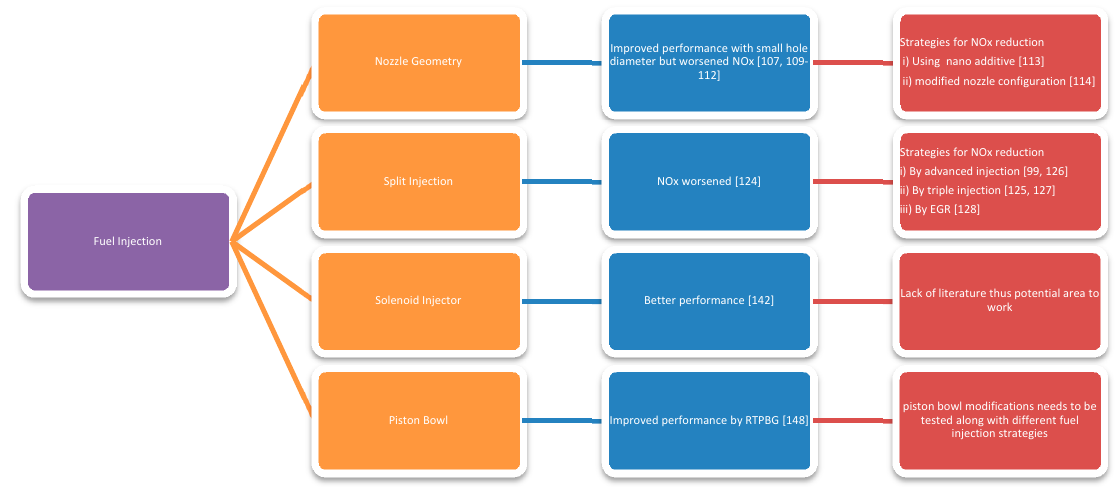
Figure 7. Schematic diagram of fuel injection modifications.